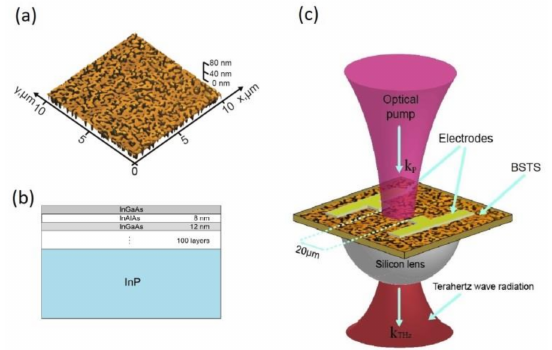
Figure 1. The ( a ) atomic force microscopy image of BSTS sample surface; ( b ) sketch of the In- GaAs/InAlAs heterostructure; and ( c ) sketch of the antenna emitter.